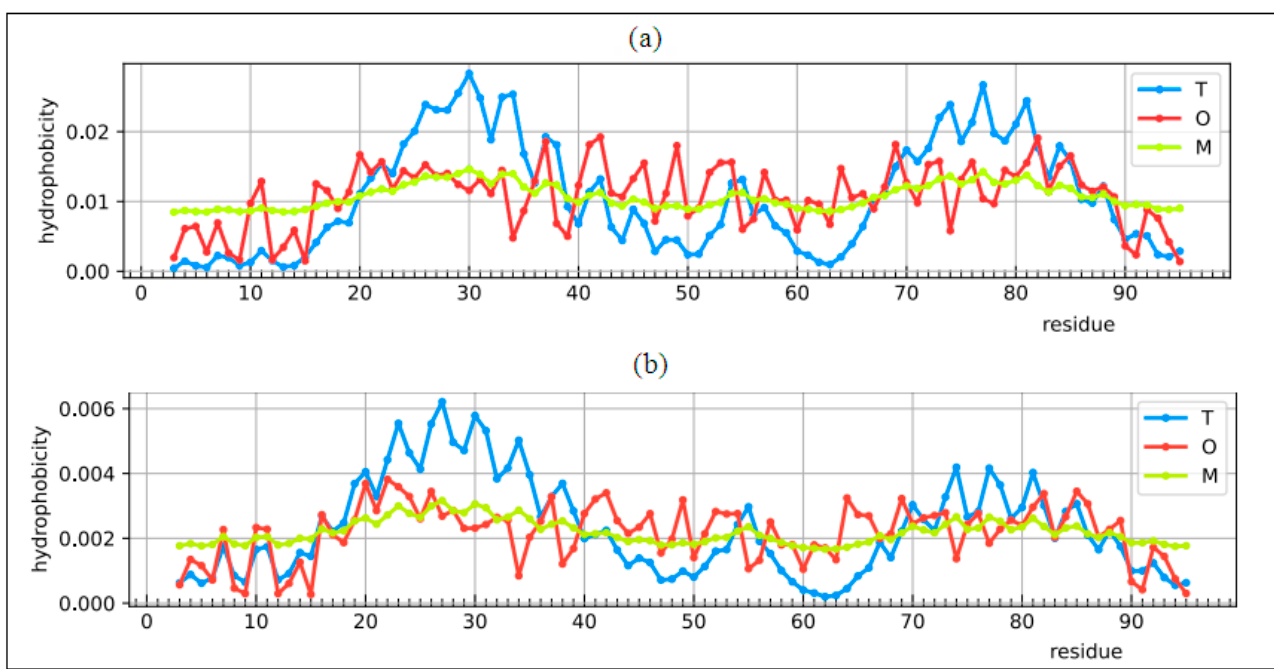
Figure 12. Characteristics of domain dom1 ( a )—profiles T, O, and M for dom1 regarded as an individual structural unit (3D Gauss function fitted for the individual domain dom1). ( b )—profiles T, O, and M for the domain dom1 regarded as an element of a complex.